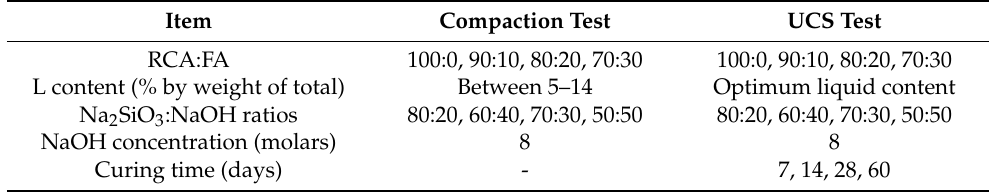
Table 2. Mix proportions of RCA-FAG